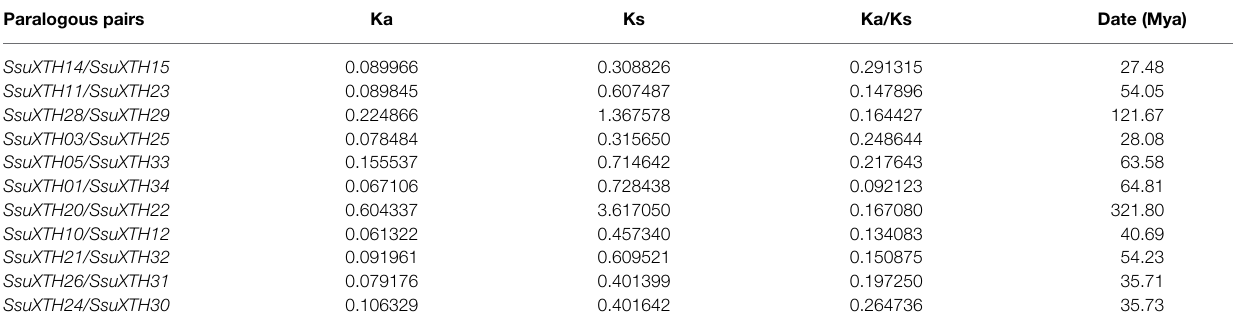
TABLE 3 | Estimated duplication times of XTH paralogous gene pairs in S. superba . Paralogous pairs